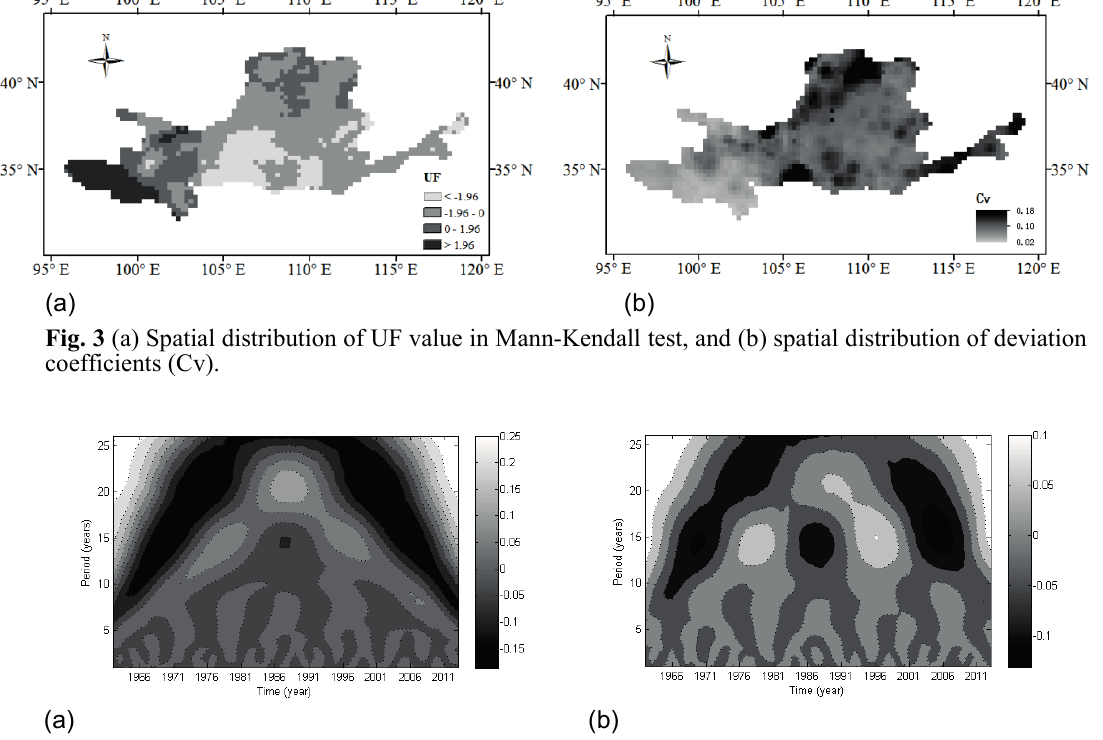
Fig. 4 (a) Morlet wavelet power spectrum for annual, and (b) Morlet wavelet power spectrum for January surface soil moisture